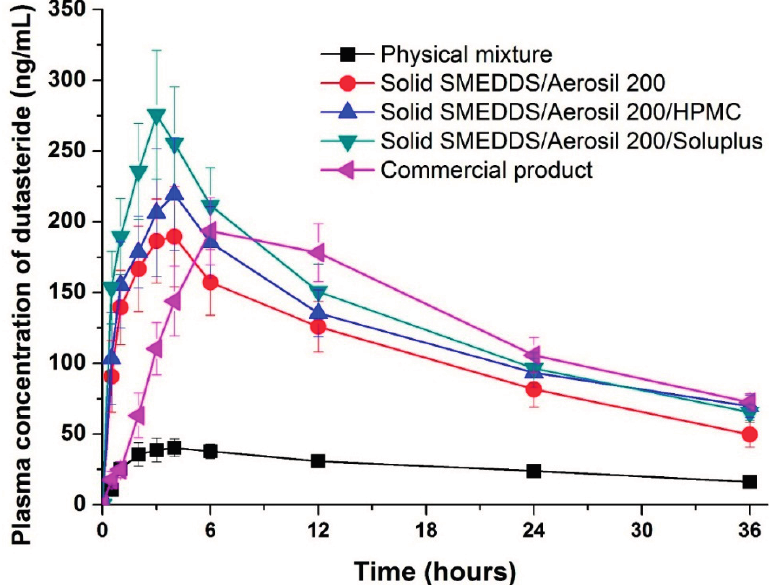
Figure 5. Plasma concentration-time profile for dutasteride in rats after oral administration of the physical mixture, dutasteride-loaded solid-supersaturatable SMEDDS, or commercial product. Data are expressed as the mean ± standard deviation ( n =